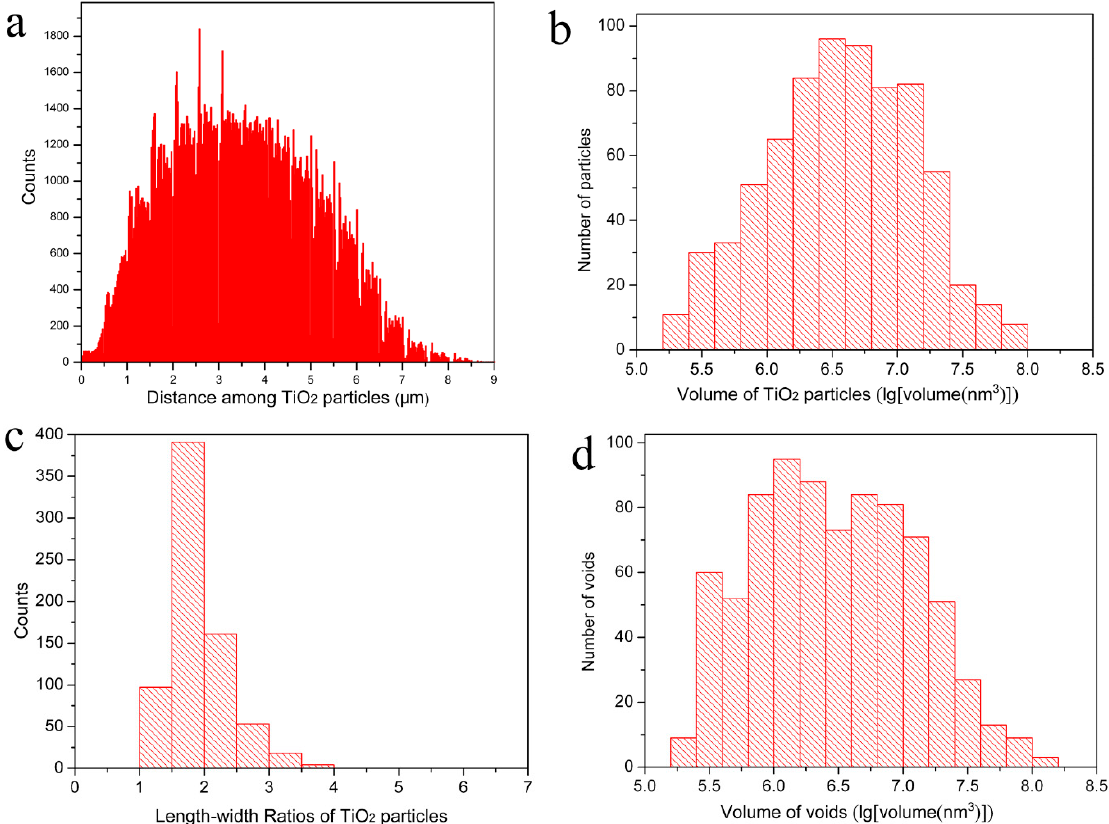
Figure 3. 3D characterization of the TiO 2 particles and voids within the measured waterborne paint film: ( a ) A histogram of distribution of distances among individual TiO 2 particles; ( b ) A histogram of the volume distribution of the TiO 2 particles; ( c ) A histogram of the length–width ratios of the measured TiO 2 particles; ( d ) A histogram of the volume distribution of the voids.